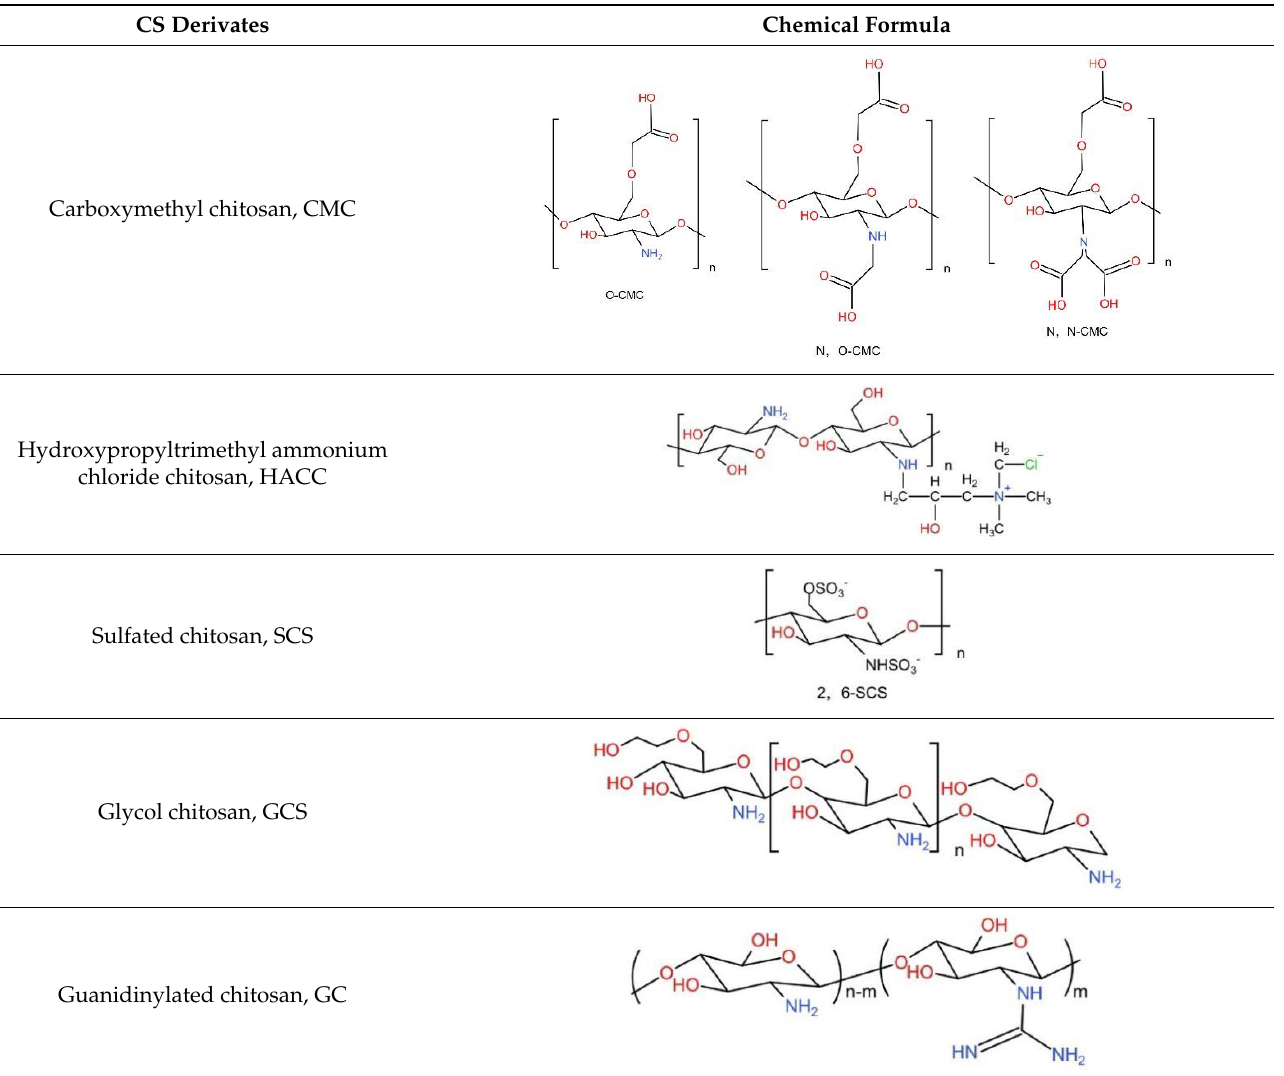
Table 5. Structural formula of structure-modified chitosan.